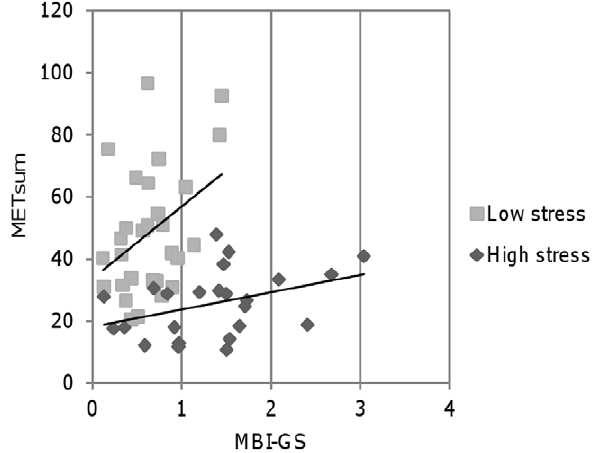
Figure 3. Methylation levels based on burnout scores in high and low work stress environments. 12 nurses in the high stress environment exhibit moderate burnout (MBI-GS . 1.5). Nurses in the low stress environment report no signs of burnout (MBI-GS , 1.5).